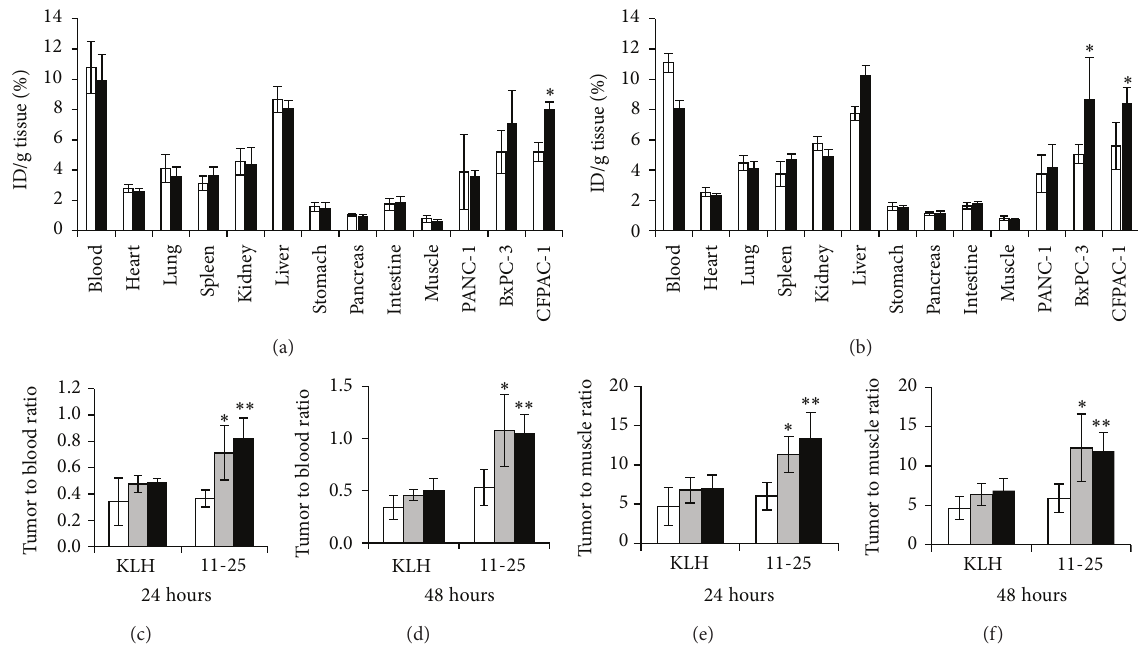
Figure 8: Biodistribution of 64 Cu-DOTA-mAbs in mice bearing BxPC-3, CFPAC-1, and PANC-1 tumors at 24 hours (a) and 48 hours (b) after intravenous injection. The mice were sacrificed at 24 hours and 48 hours after intravenous injection of 11MBq of 64 Cu-DOTA-11-25 mAb (blackbars)or 64 Cu-DOTA-anti-KLHmAb(whitebars).Theorganswerecollectedandweighedandradioactivitywasmeasuredby 𝛾 -counter. ∗ 𝑃 < 0.05 versus the accumulation of 64 Cu-DOTA-anti-KLH mAb. Tumor to blood ratio of 64 Cu-lableld 11-25 mAb and 64 Cu-DOTA-anti- KLH mAb in the tumors at 24 hours (c) and 48 hours (d) after injection of PANC-1 (white bars), BxPC-3 (gray bars), and CFPAC-1 (black bars). Tumor to muscle ratio of 64 Cu-lableld 11-25 mAb and 64 Cu-DOTA-anti-KLH mAb in the tumors at 24 hours (c) and 48 hours (d) after injection of PANC-1 (white bars), BxPC-3 (gray bars), and CFPAC-1 (black bars). The data were calculated as percentage of injected dose per gram of tissue (%ID/g). Mean and standard deviation have been corrected for physical decay of 64 Cu. ∗ 𝑃 < 0.05 , ∗∗ 𝑃 < 0.01 versus the ratio of PANC-1